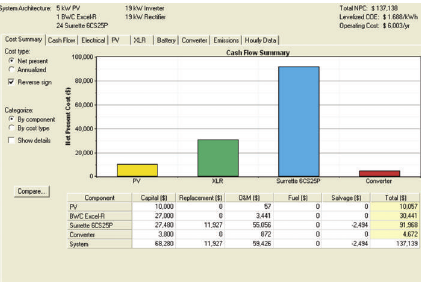
Figure 10: Cost summary of the integrated renewable energy sys- tem.